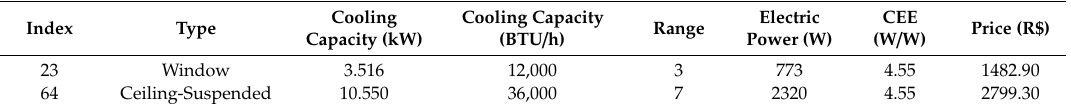
Table 3. “Baits” equipment included in the “Air conditioning” input